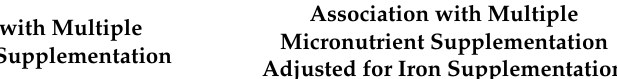
Table 4. Subgroup comparison assessing the confounding effect of iron supplementation on the associations between multiple micronutrient supplementation in pregnancy and indices of size at birth and